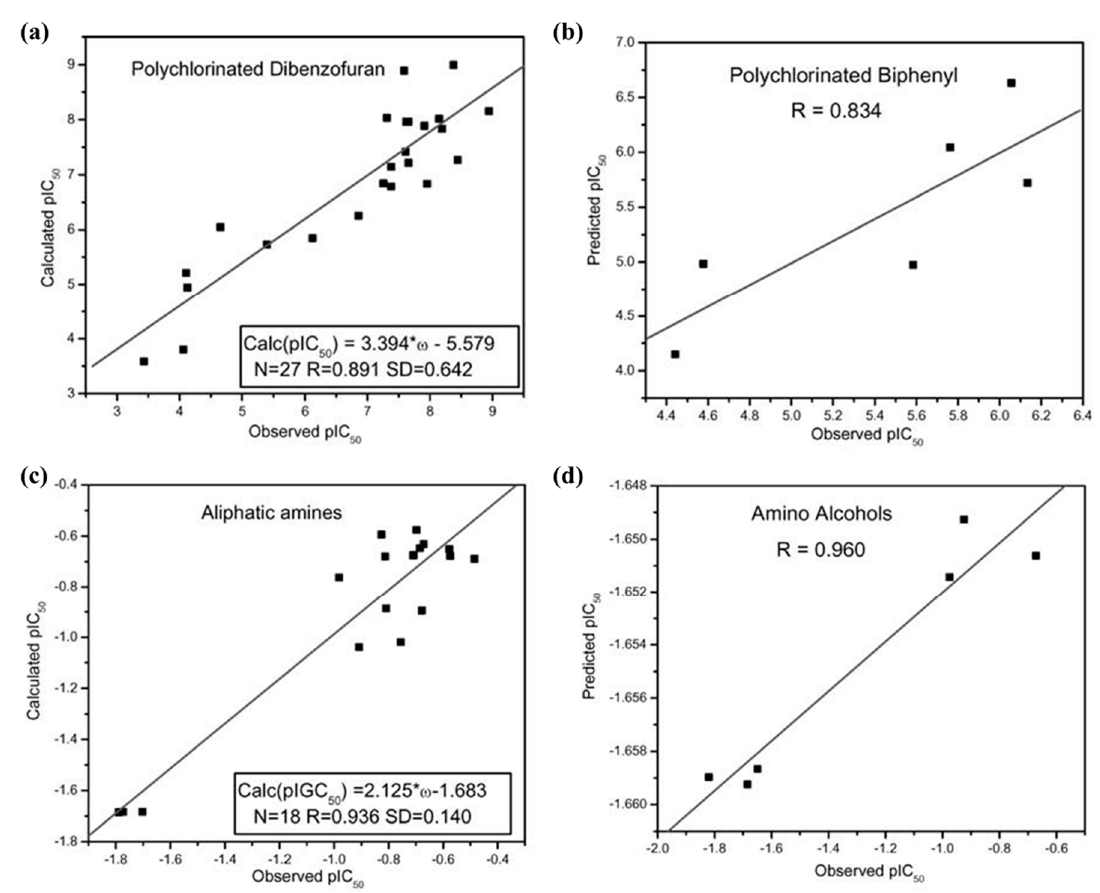
Figure 4. Plots of calculated vs. observed pIC 50 for ( a ) training set of PCDFs, ( b ) test set of PCBs, ( c ) training set of aliphatic amines, and ( d ) test set of amino alcohols (adapted from Ref. [77] with permission from Springer Nature. © 2006, Springer Science Business Media, Inc.).